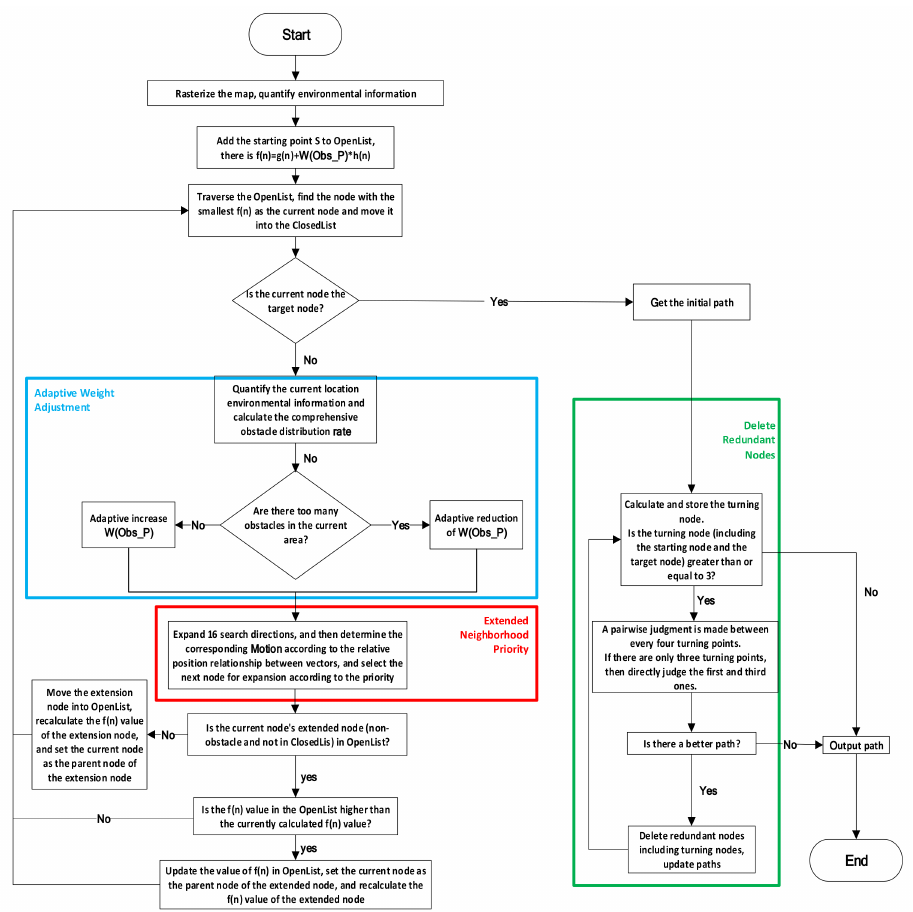
Figure 11. ENMSA-A* algorithm